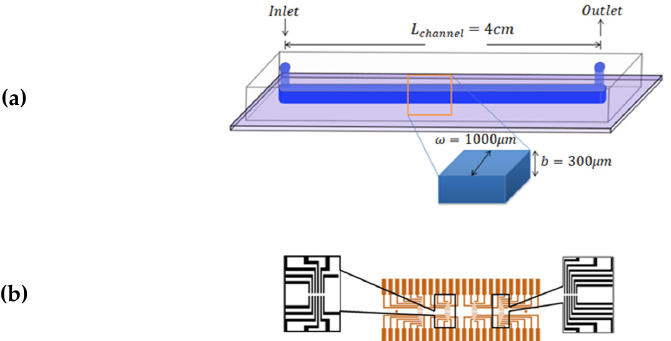
Figure 4. Schematics of the microfluidic consumable. ( a ) The microfluidic channel made of PDMS sealed on a glass substrate. The channel dimensions are ω = 1000 μ m,b = 300 μ m , and L (cid:2913) = 4 cm. sealed on a glass substrate. The channel dimensions are ω = 1000 µ m, b = 300 µ m, and L c = 4 cm. ( b ) Gold electrodes printed on the glass surface and beneath the PDMS layer. ( b ) Gold electrodes printed on the glass surface and beneath the PDMS